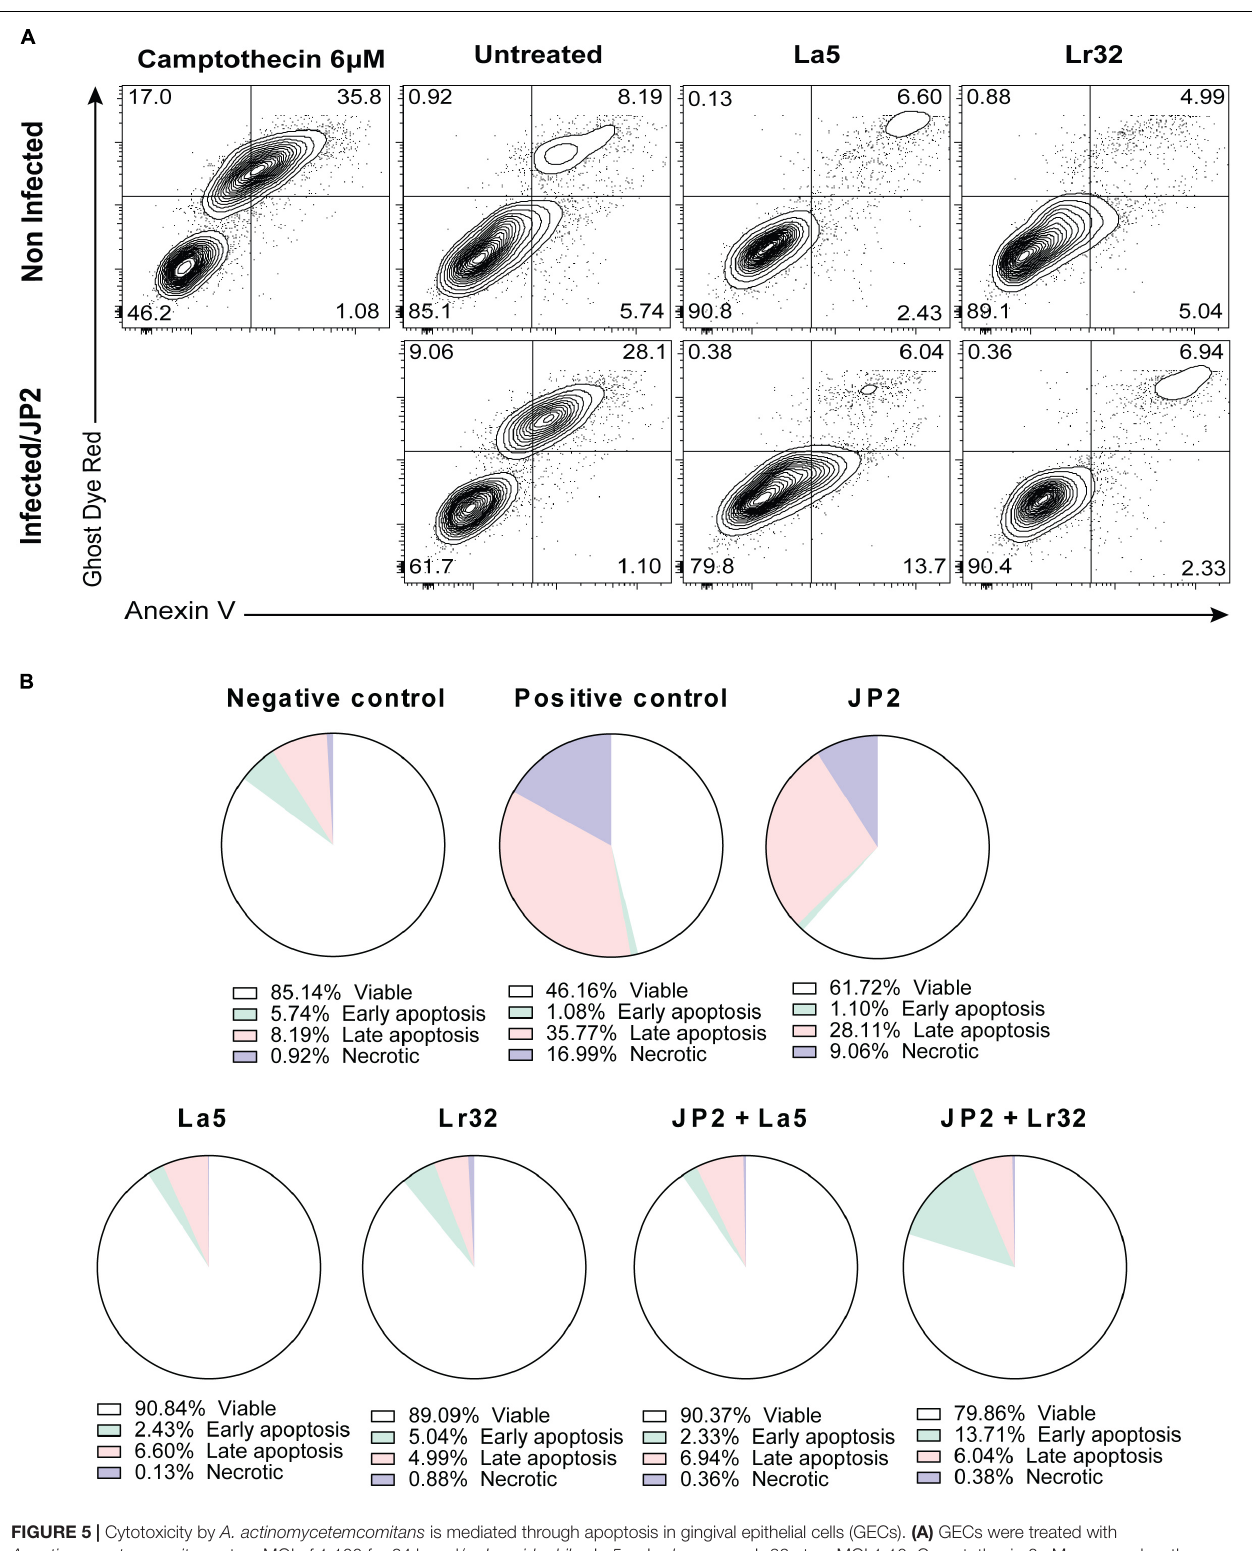
Frontiers in Microbiology |